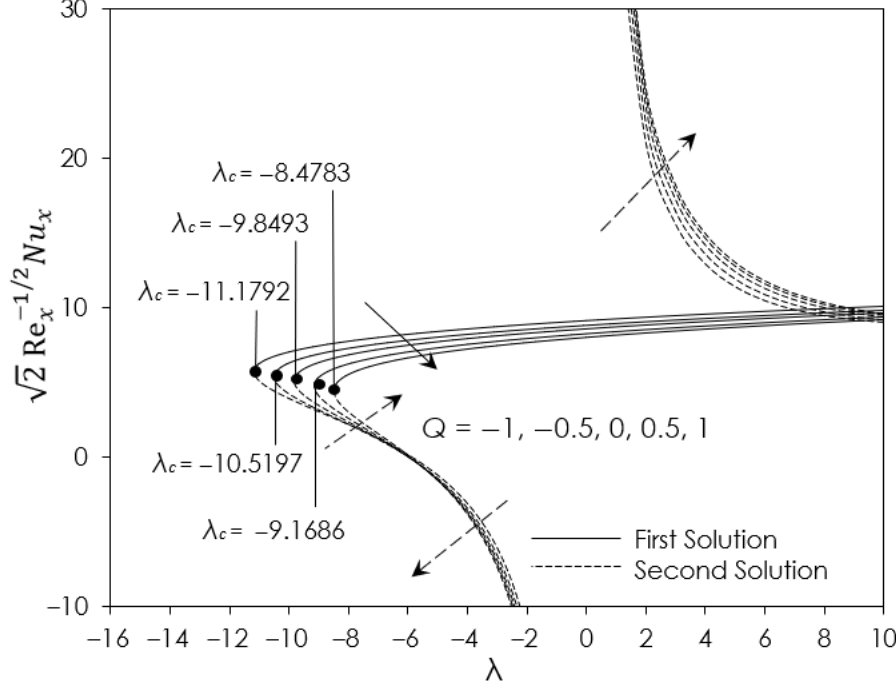
√ 2 Re − 1/2 x Nu x for different values of Q